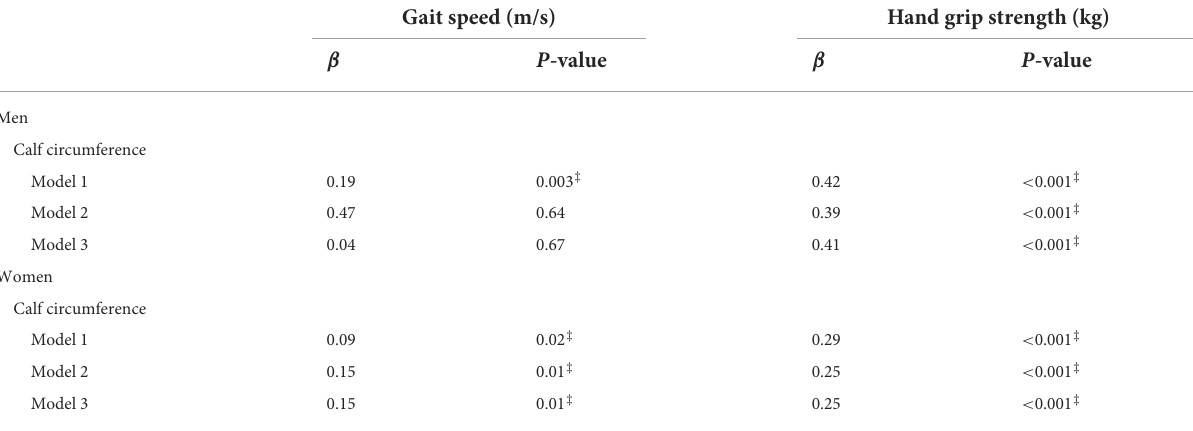
TABLE 3 Multivariate linear regression analyses of physical performance by calf circumference, presented with gender